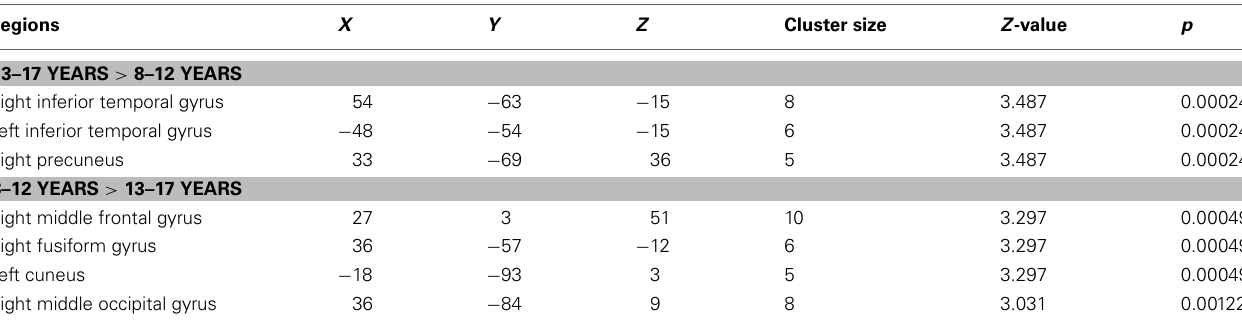
Table 2 | Neural substrates of subsequent memory effect (Dm) for neutral faces across ages Whole brain